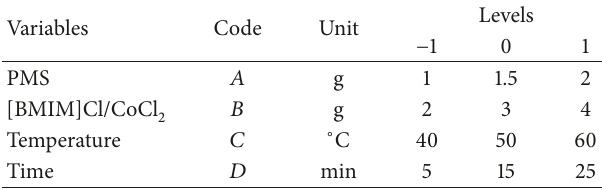
Table 1: Levels of the variables for BBD experimental design.